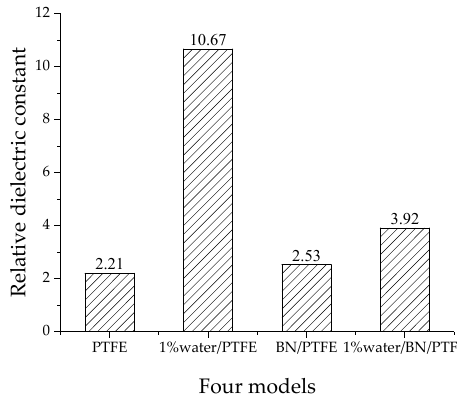
Figure 11. Relative dielectric constant of four models.